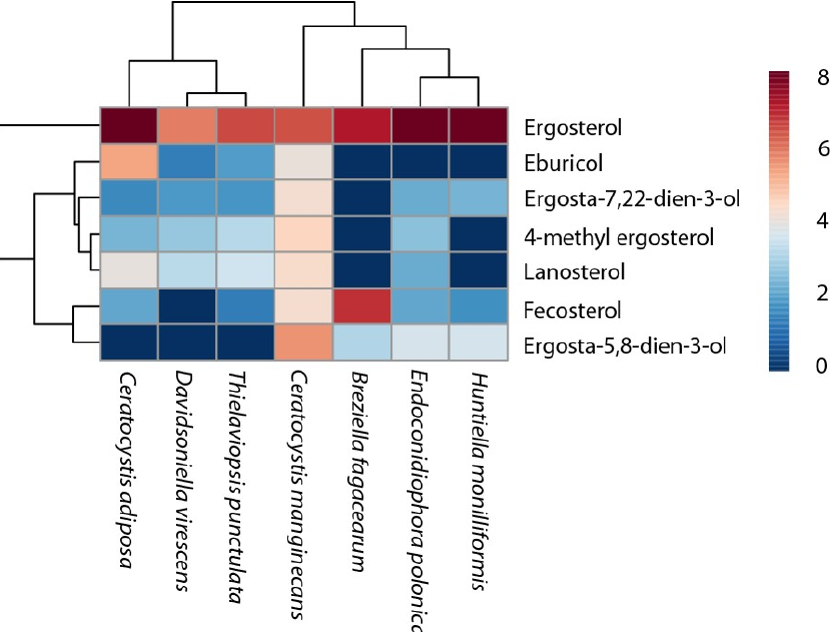
Figure 5. Heatmap of the sterol composition and ergosterol content in mycelia of isolates of the Ceratocystidaceae species: C. manginecans , H. moniliformis , T. punctulata , B. fagacearum , E. polonica and D. virescens grown in the MEB media for seven days. All three replicates are shown. Red and blue colours indicate higher and lower concentrations of the compounds, respectively.